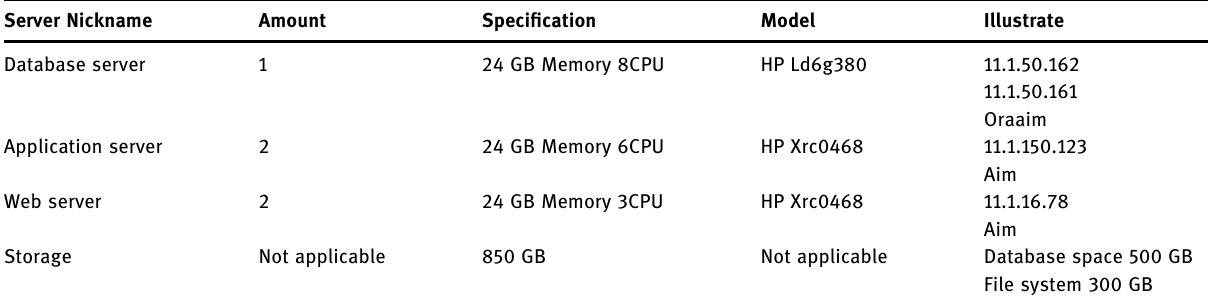
Table 1: Server hardware con fi guration